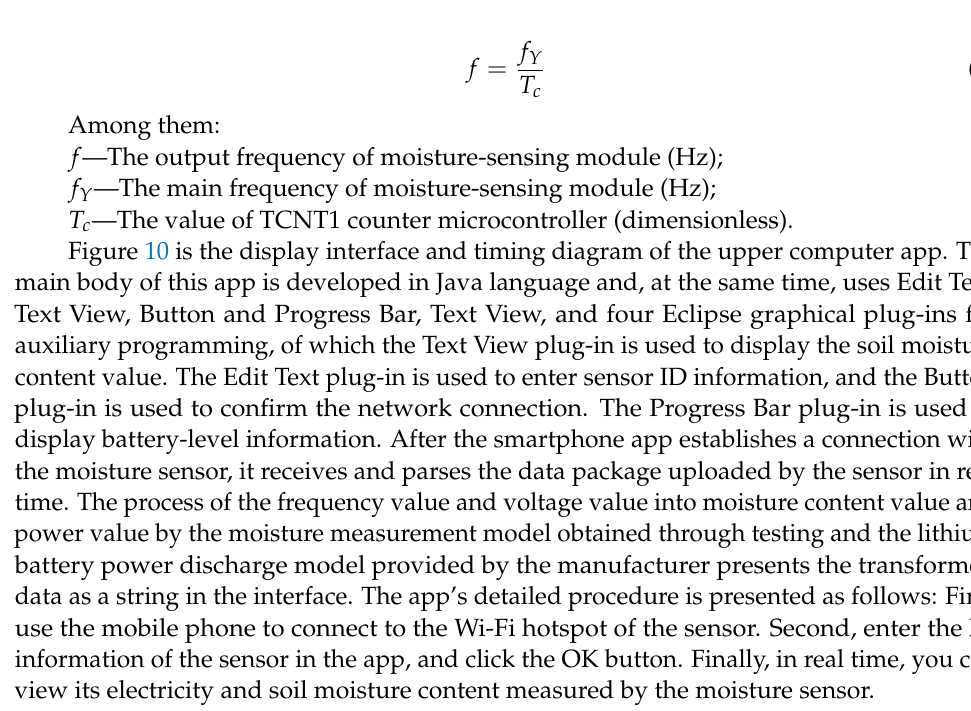
Figure 9. Frequency measurement timing diagram.